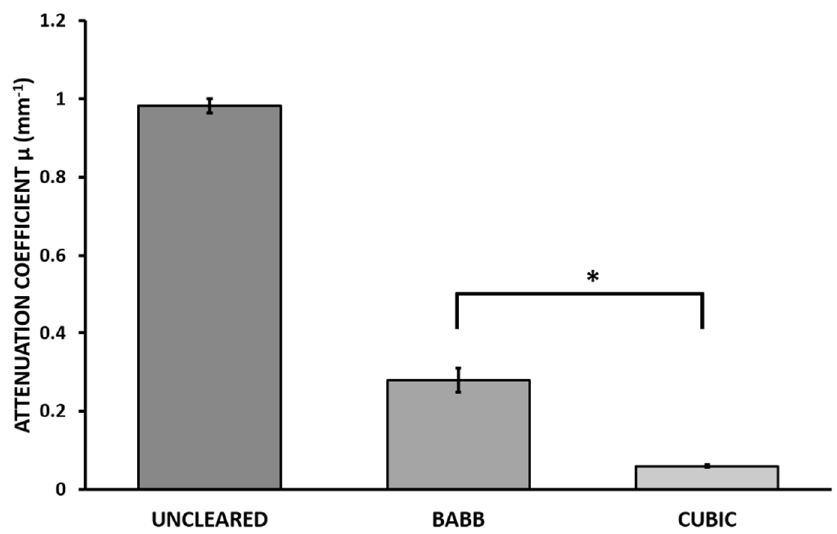
Figure 5. Attenuation coefficients μ (mm − 1 ) for each of the images obtained from uncleared, post-BABB incubation, and post-CUBIC 1-A incubation human melanoma samples (data represent mean ± SEM, * p < 0.001, one-way ANOVA plus Bonferroni post-test).